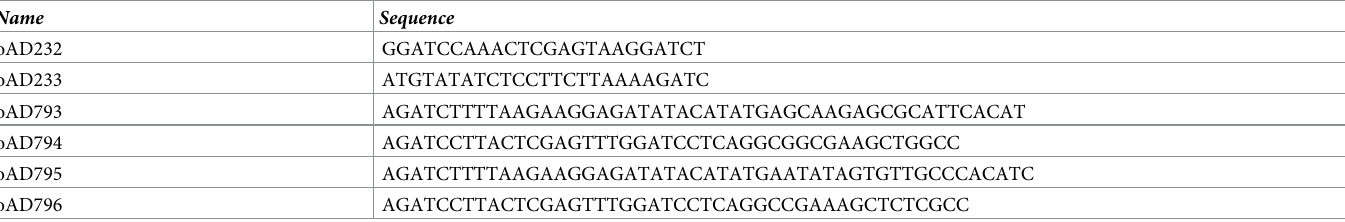
Table 1. Oligonucleotide